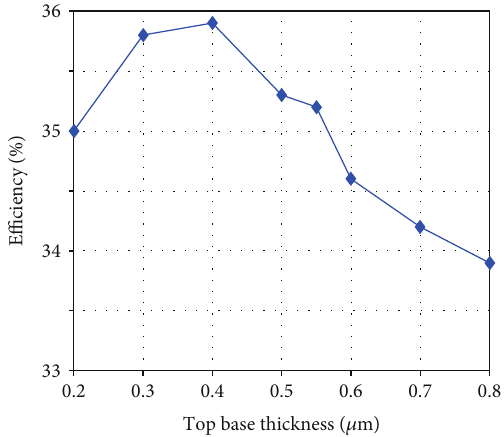
Figure 4: Cell e ffi ciency vs. top base